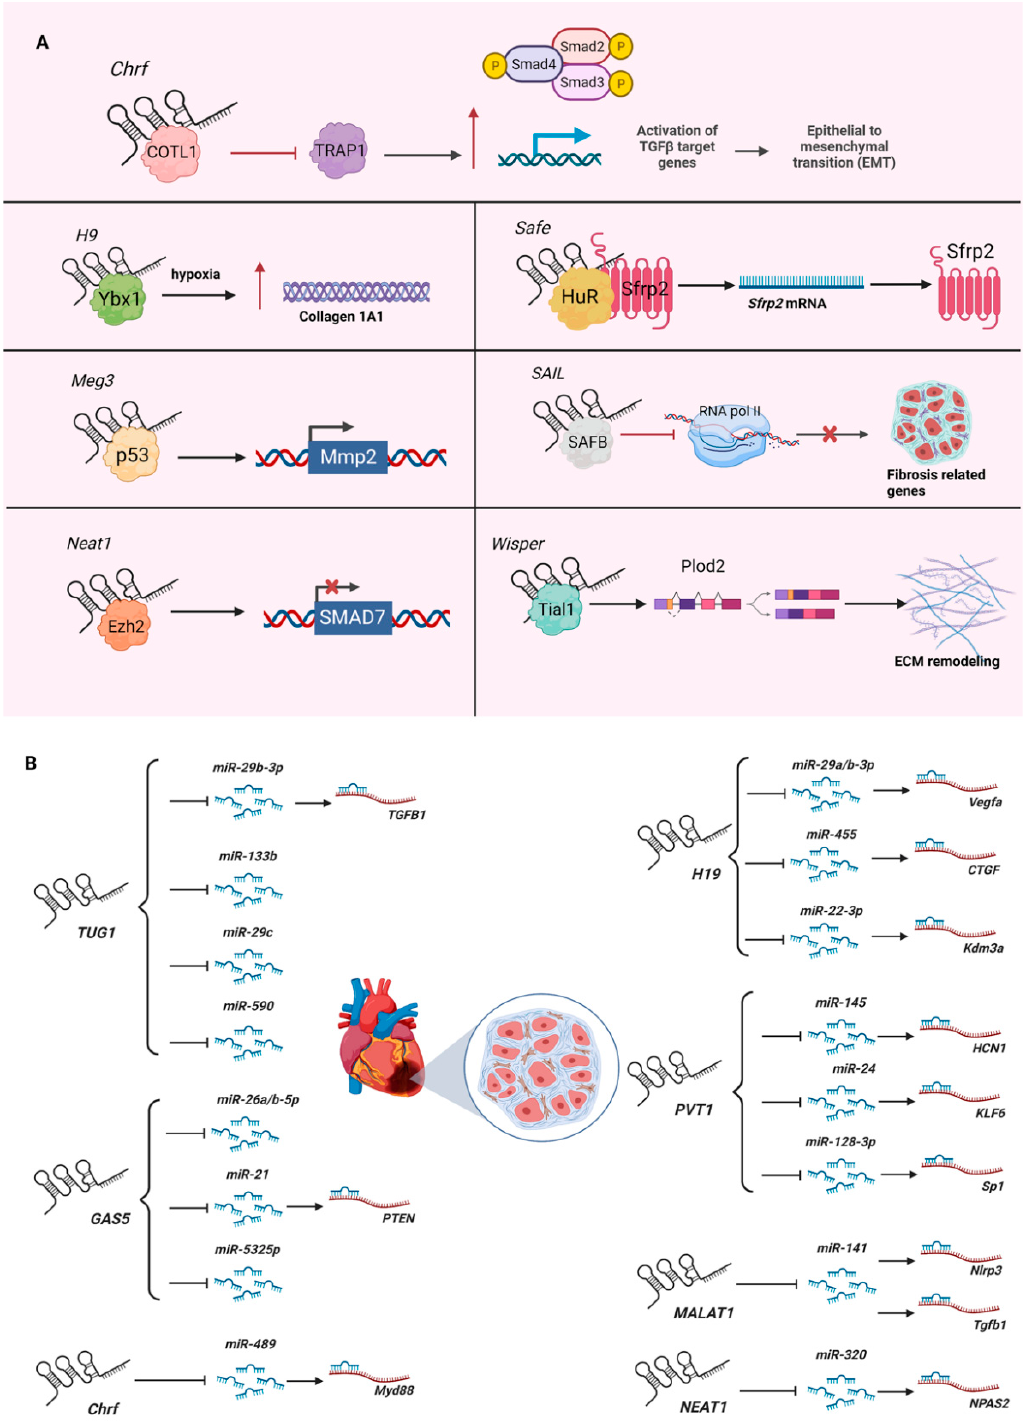
Figure 1. Role of lncRNAs in cardiac fibrosis: ( A ) Mechanisms of action of lncRNAs in the pathogenesis of cardiac fibrosis. ( B ) LncRNAs as miRNA sponges for cardiac fibromiRs. Please see Table 1 for mechanistic descriptions. Figure created with BioRender.com, accessed on 22 June 2022.